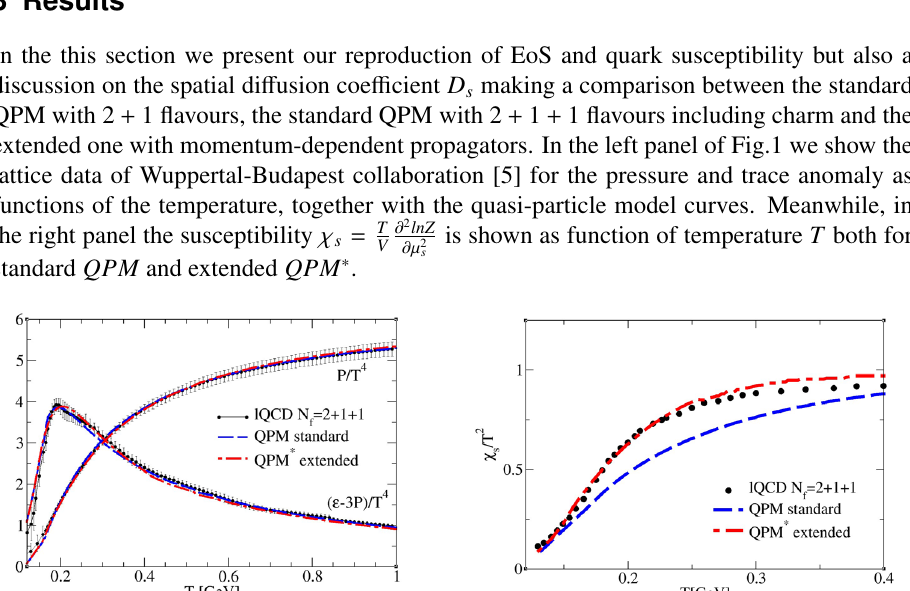
3 p ) / T 4 (left panel) and susceptibility χ s = T −